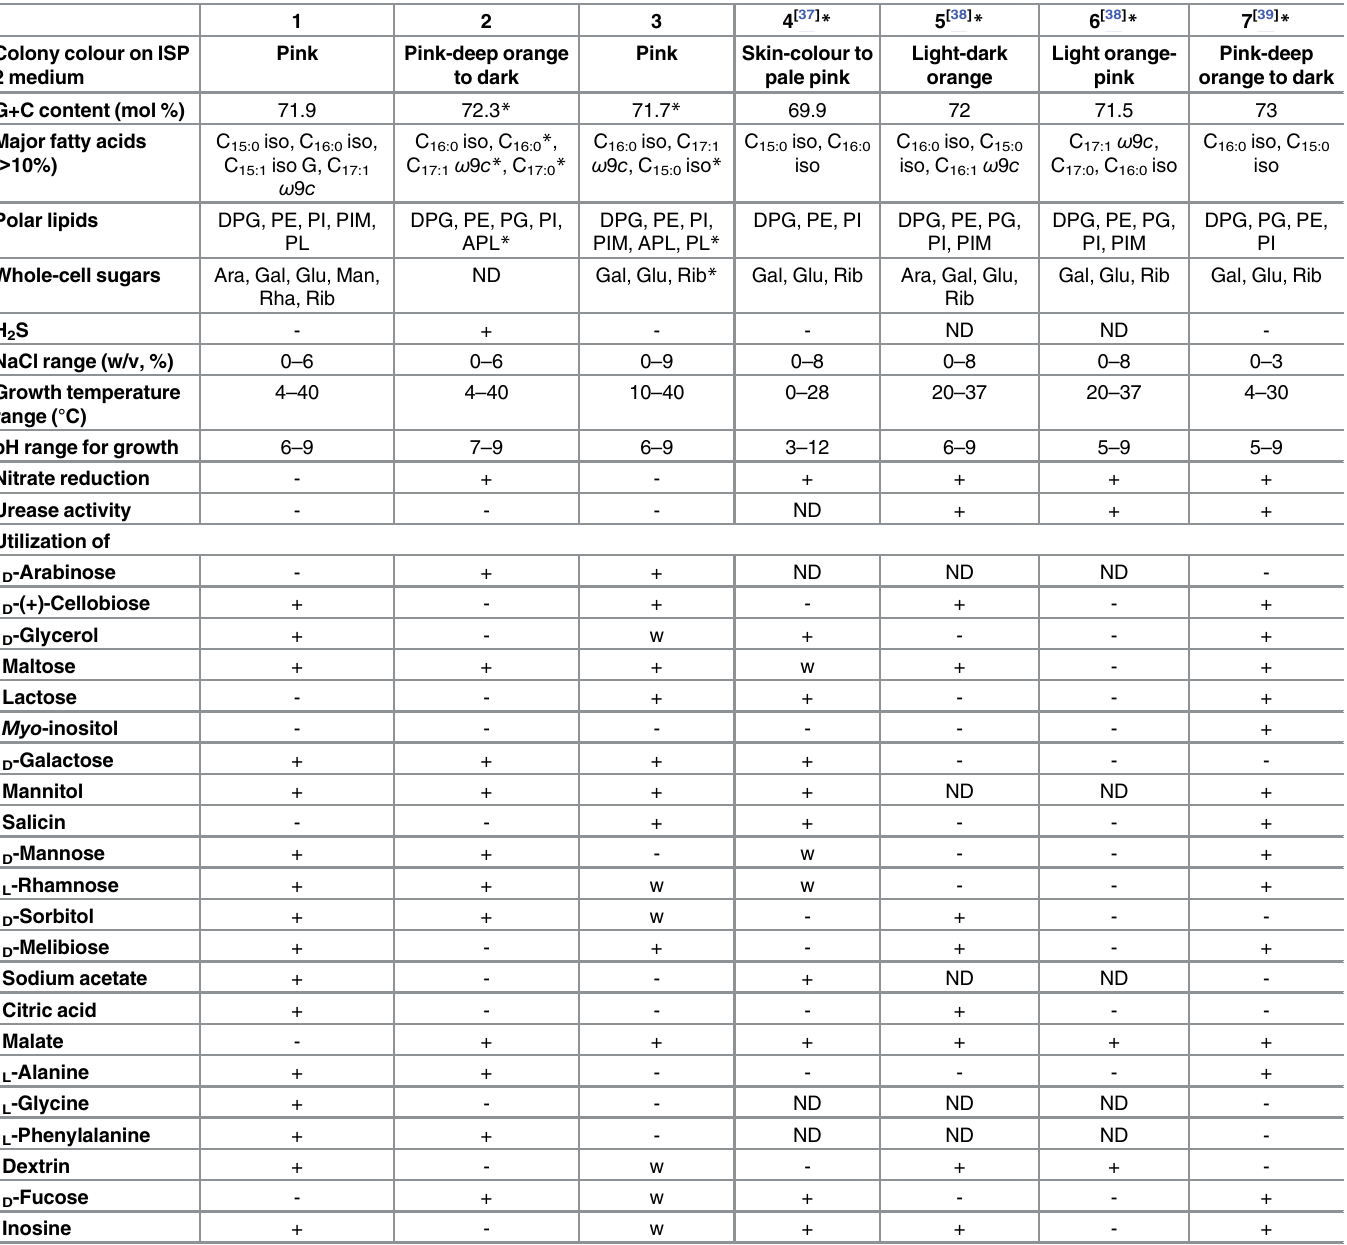
Table 1. Comparative characteristics between strain JXJ CY 19 T and other members of the genus Modestobacter . 1